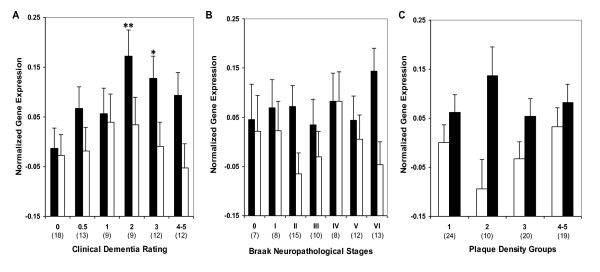
Normalized RXRα (Black bars) and LXRβ mRNA (white bars) expression in hippocampus plotted against CDR scores, Braak neuropathological stages and NP density groups. ANCOVA was used to compare gene expression in individuals with varying degree of dementia (CDR 0.5-5) and AD-associated neuropathology (Braak stage I-VI, NP density 2-5) relative to the control group. Mean values ± SEM are shown. *, p < 0.05; **, p < 0.01. Number within the parentheses indicates the individuals within control groups and each of the disease severity group.